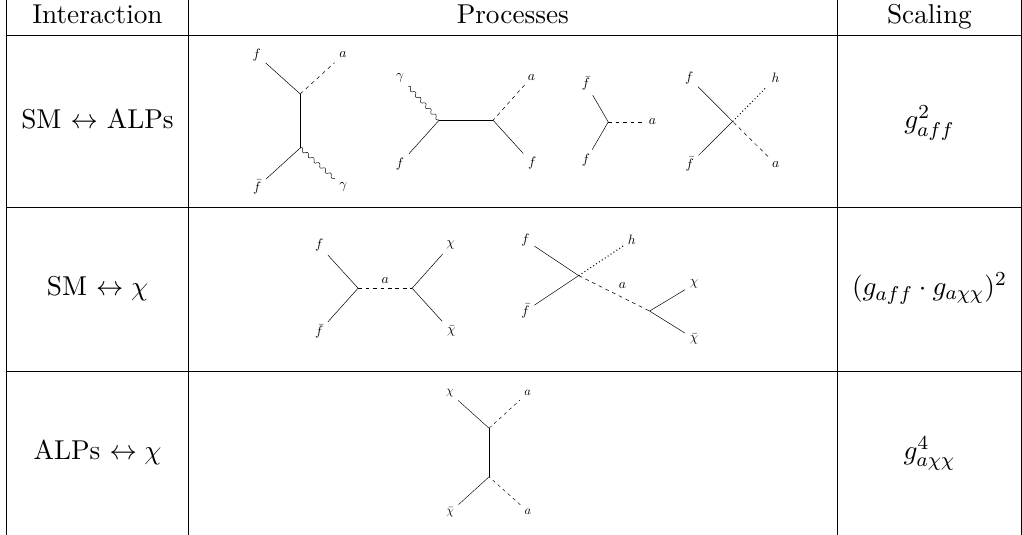
Table 1 . Different sector interaction processes and their scaling with the hidden sector and con- nector couplings. Note that the diagrams f ¯ f ↔ γa and fγ ↔ fa shown are equivalent to those